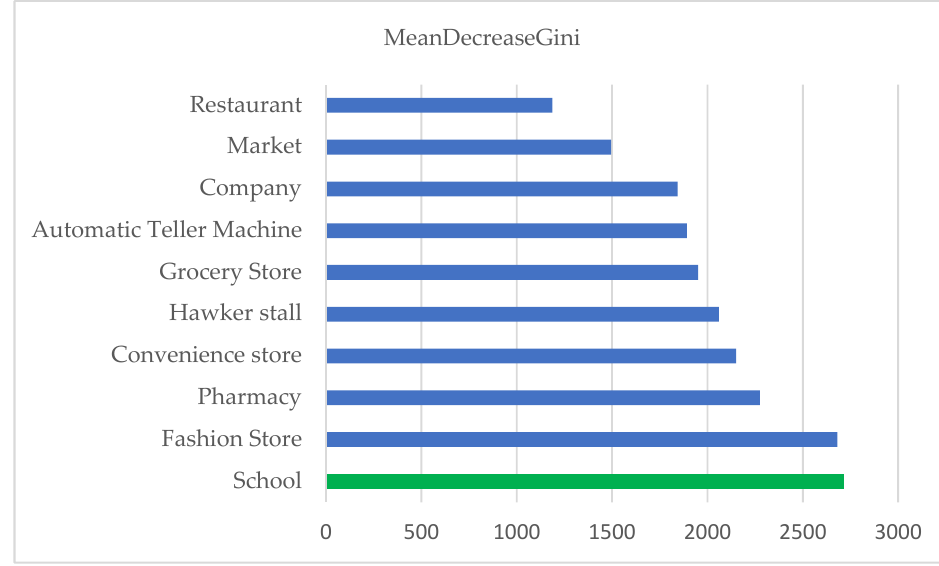
Figure 12. The factor importance is measured using random forest.